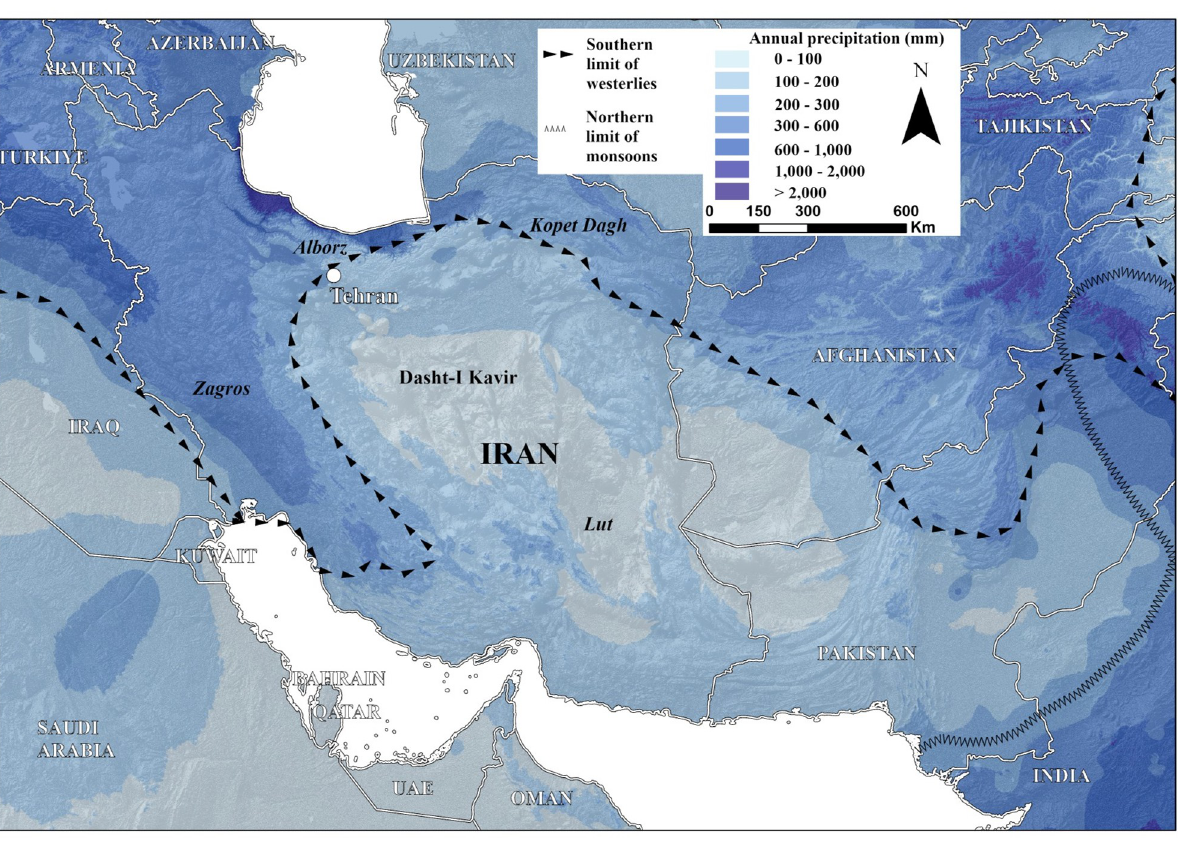
Fig 2. Modern mean annual precipitation for Iran (WorldCLIM). Map depicts the current limits of westerly and monsoonal moisture overlain on monthly rainfall through the year. Monsoon limits come from quantitative analyses of global monsoons [46, 47]. Higher rainfall is found in the north and west, particularly in the Zagros, Alborz and Kopet Dagh Mountains further south rainfall declines in the Dasht-I Kavir and Lut Deserts. Map created by one of our authors (PSB).